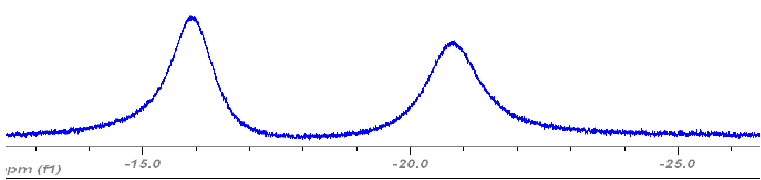
Figure 1. Example of paramagnetic 1 H nuclear magnetic resonance (NMR) spectrum, in this case corresponding to 6 .